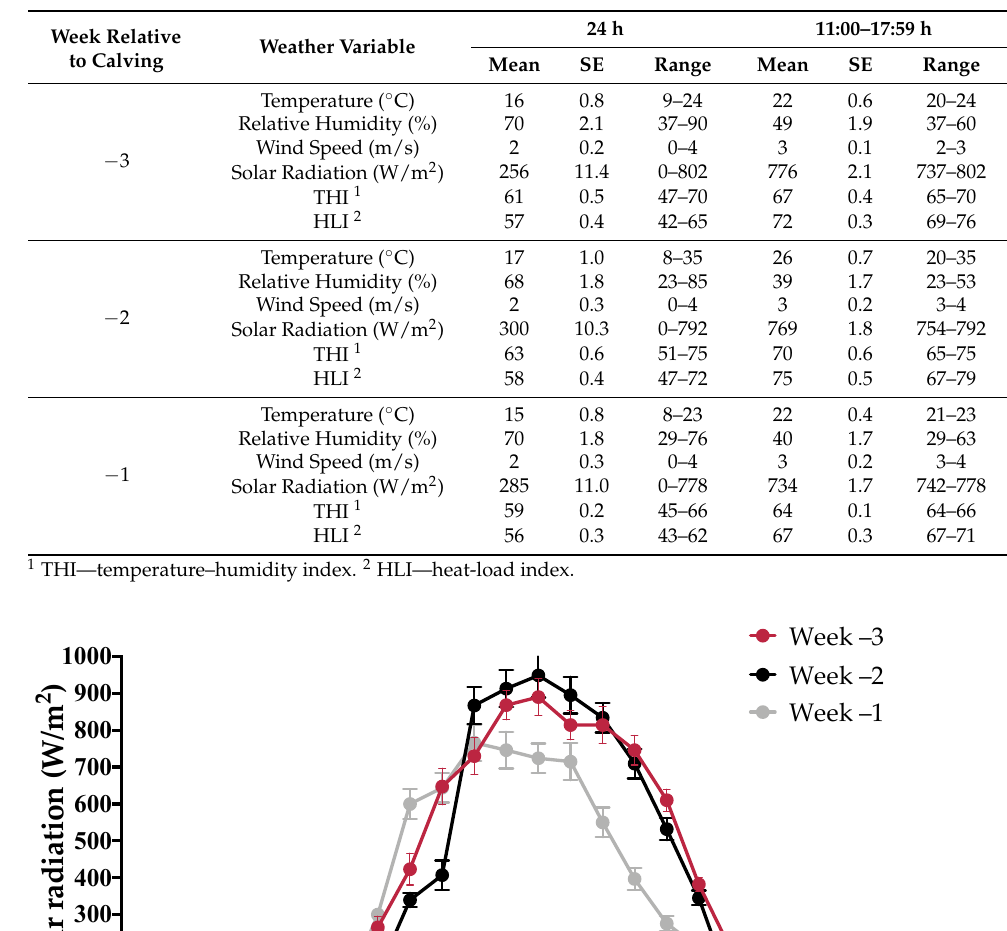
Table 1. Weekly summary (mean, Standard Error (SE), range) of summer weather variables recorded over 24 h and from 11:00 to 17:59 h during three weeks before calving.